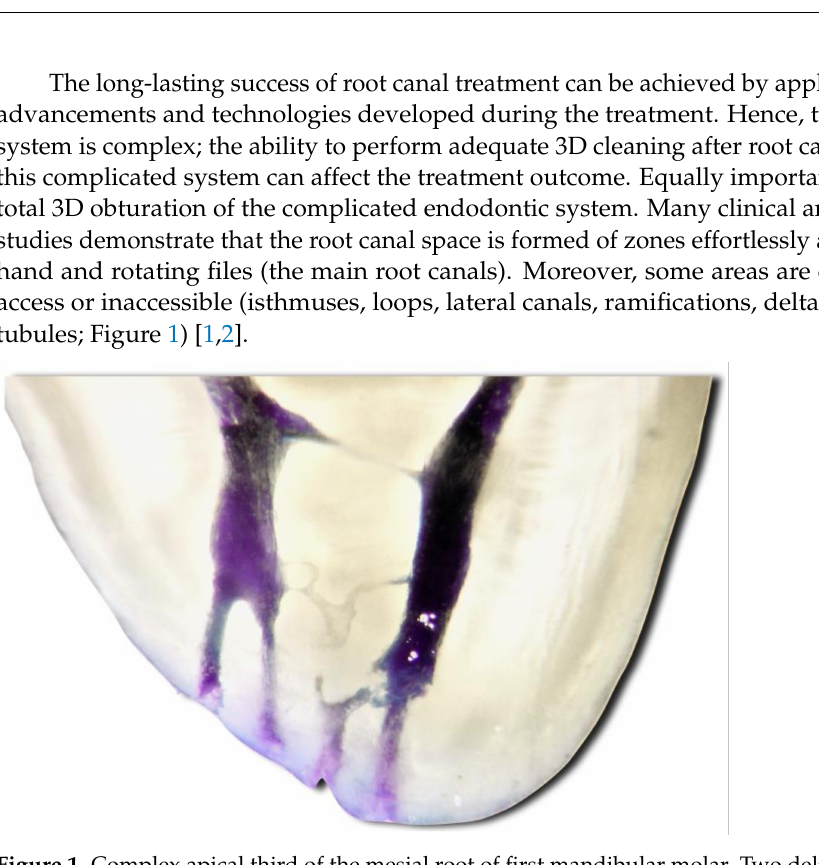
Figure 1. Complex apical third of the mesial root of first mandibular molar. Two deltas and multiple interconnections can be